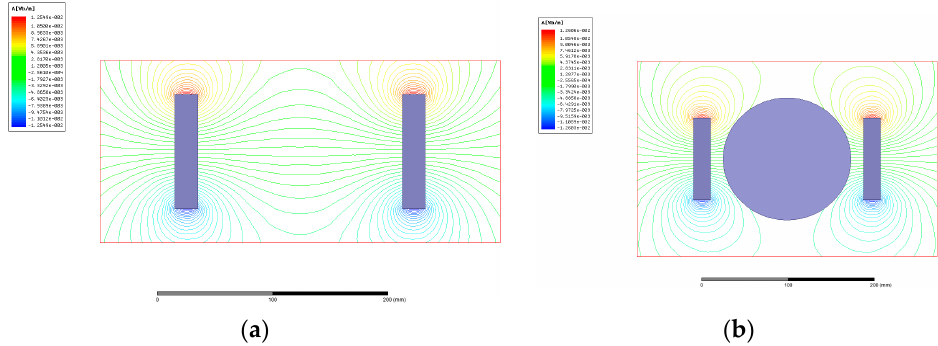
Figure 3. Magnetic-induction-line distribution comparison (left is N pole, right is S pole), ( a ) without workpiece, ( b ) with workpiece.